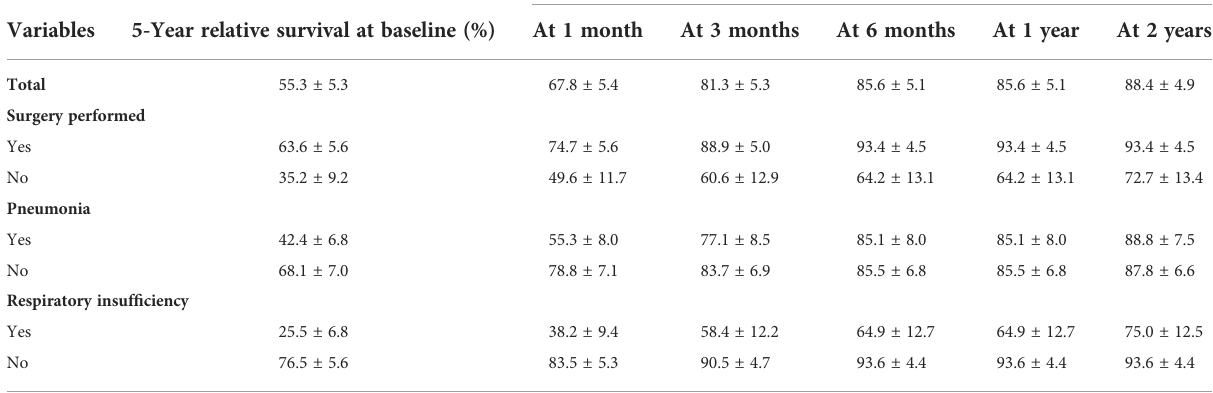
TABLE 3 Five-year conditional survival rates among ASIA A and B grade